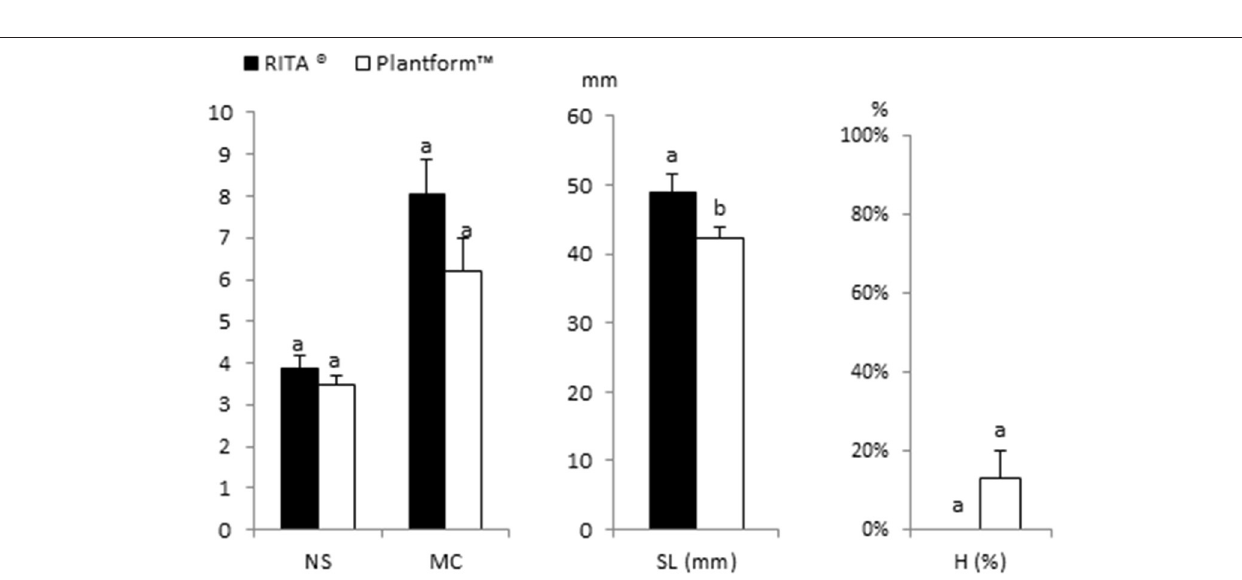
FIGURE 6 | Proliferation of apical vs. basal sections of Beatriz genotype cultured in RITA ® vessels in β -A medium supplemented with 2- µ M metatopoline. Explants (8 per vessel) were immersed for 1min every 8h. The data were recorded after 4 weeks of culture. The values represent the mean ± standard error. For each variable, different letters indicate significant differences at p < 0.05. NS, number of shoots per explant; MC, multiplication coefficient; SL, length of the longest shoot (mm); H, percentage of hyperhydric shoots.